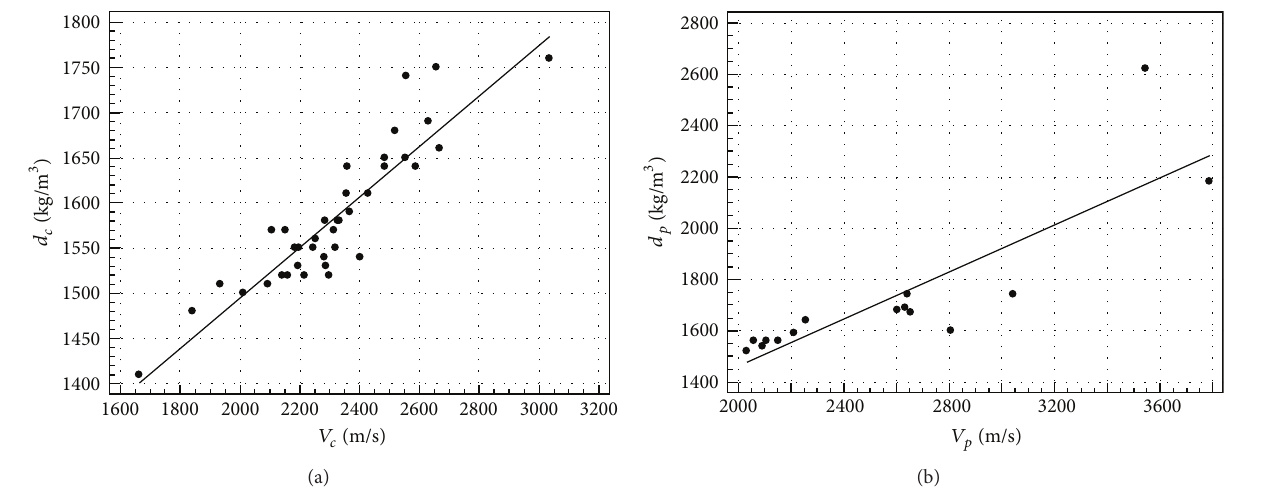
Figure 4: Regression of ultrasonic velocity and density in cubes (a) and prisms (b).